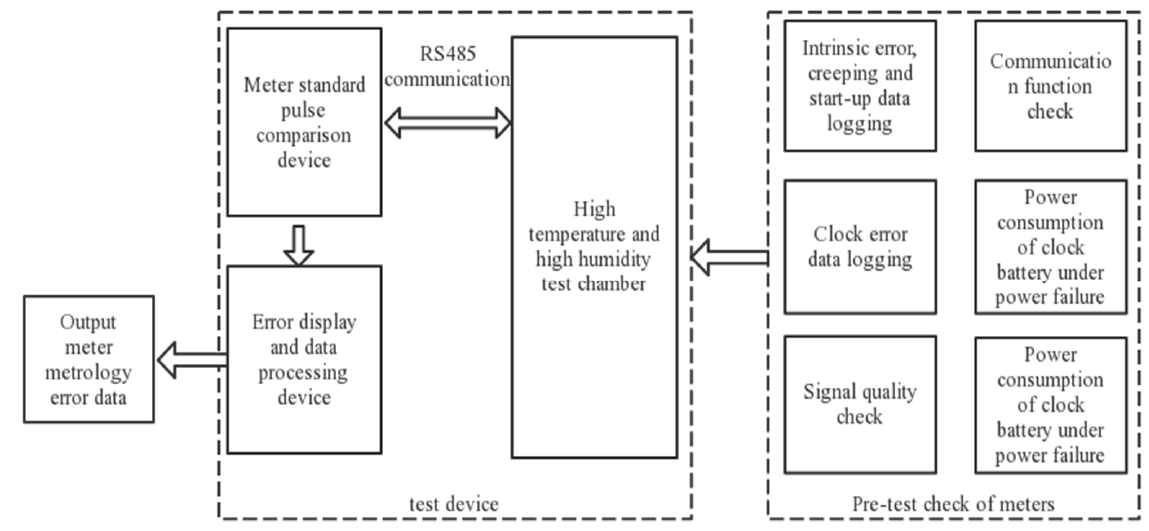
Figure 3. Schematic diagram of test flow.